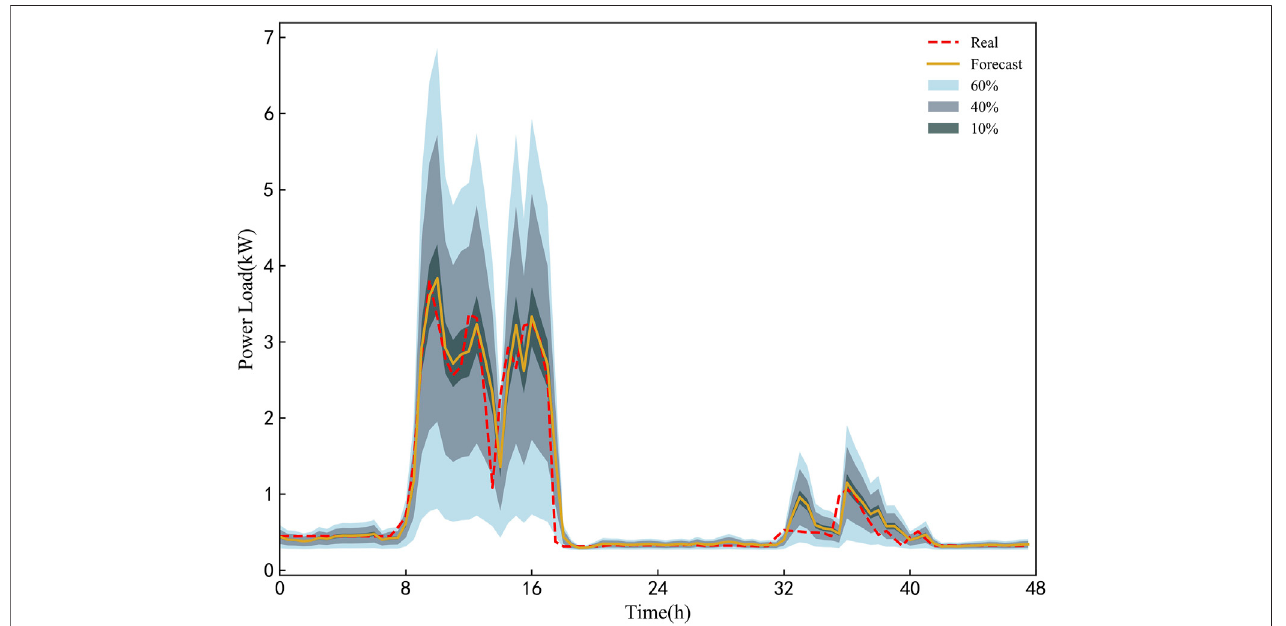
FIGURE 13 | PIs under different con fi dence levels obtained by the proposed ConvLSTM-MDN model in experiment 3.